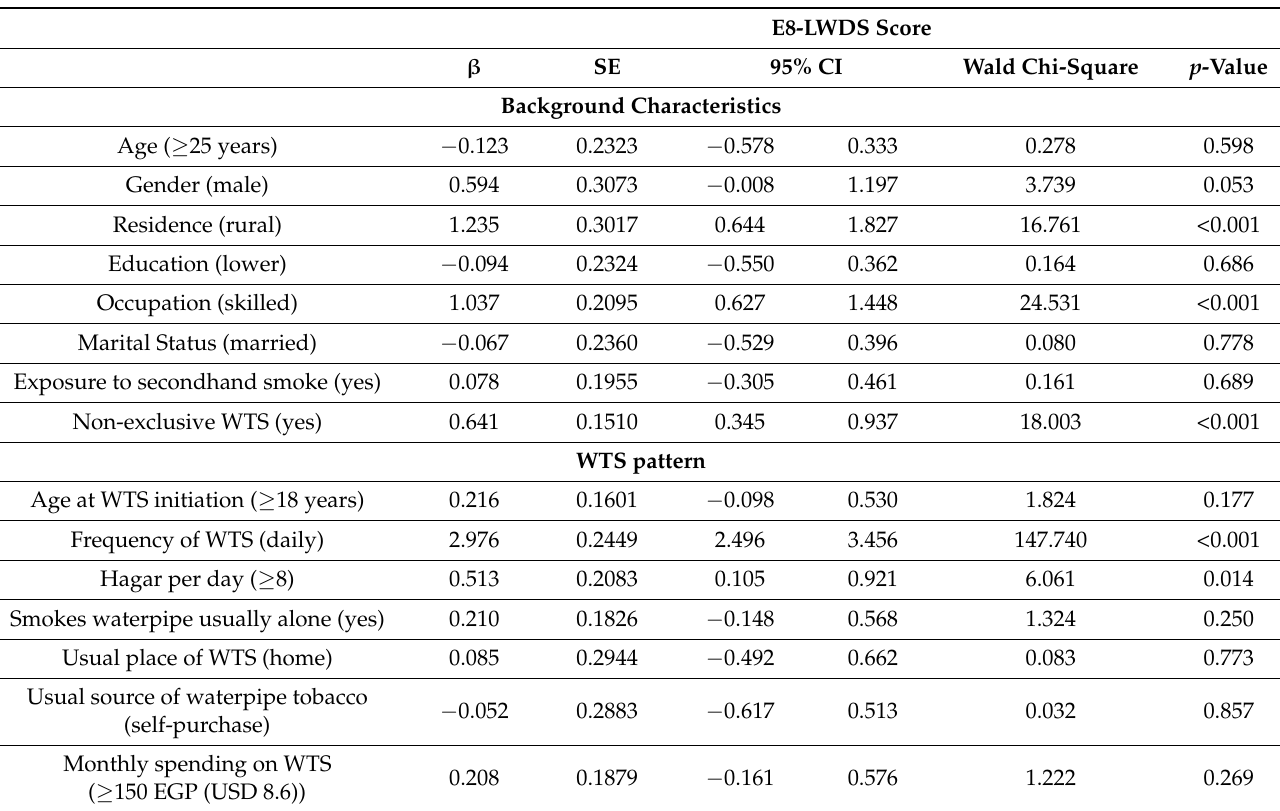
Table 4. Generalized linear model for associations of E8-LWDS score with background characteristics, WTS pattern, perceived harm, and perceived behavioral control of waterpipe tobacco